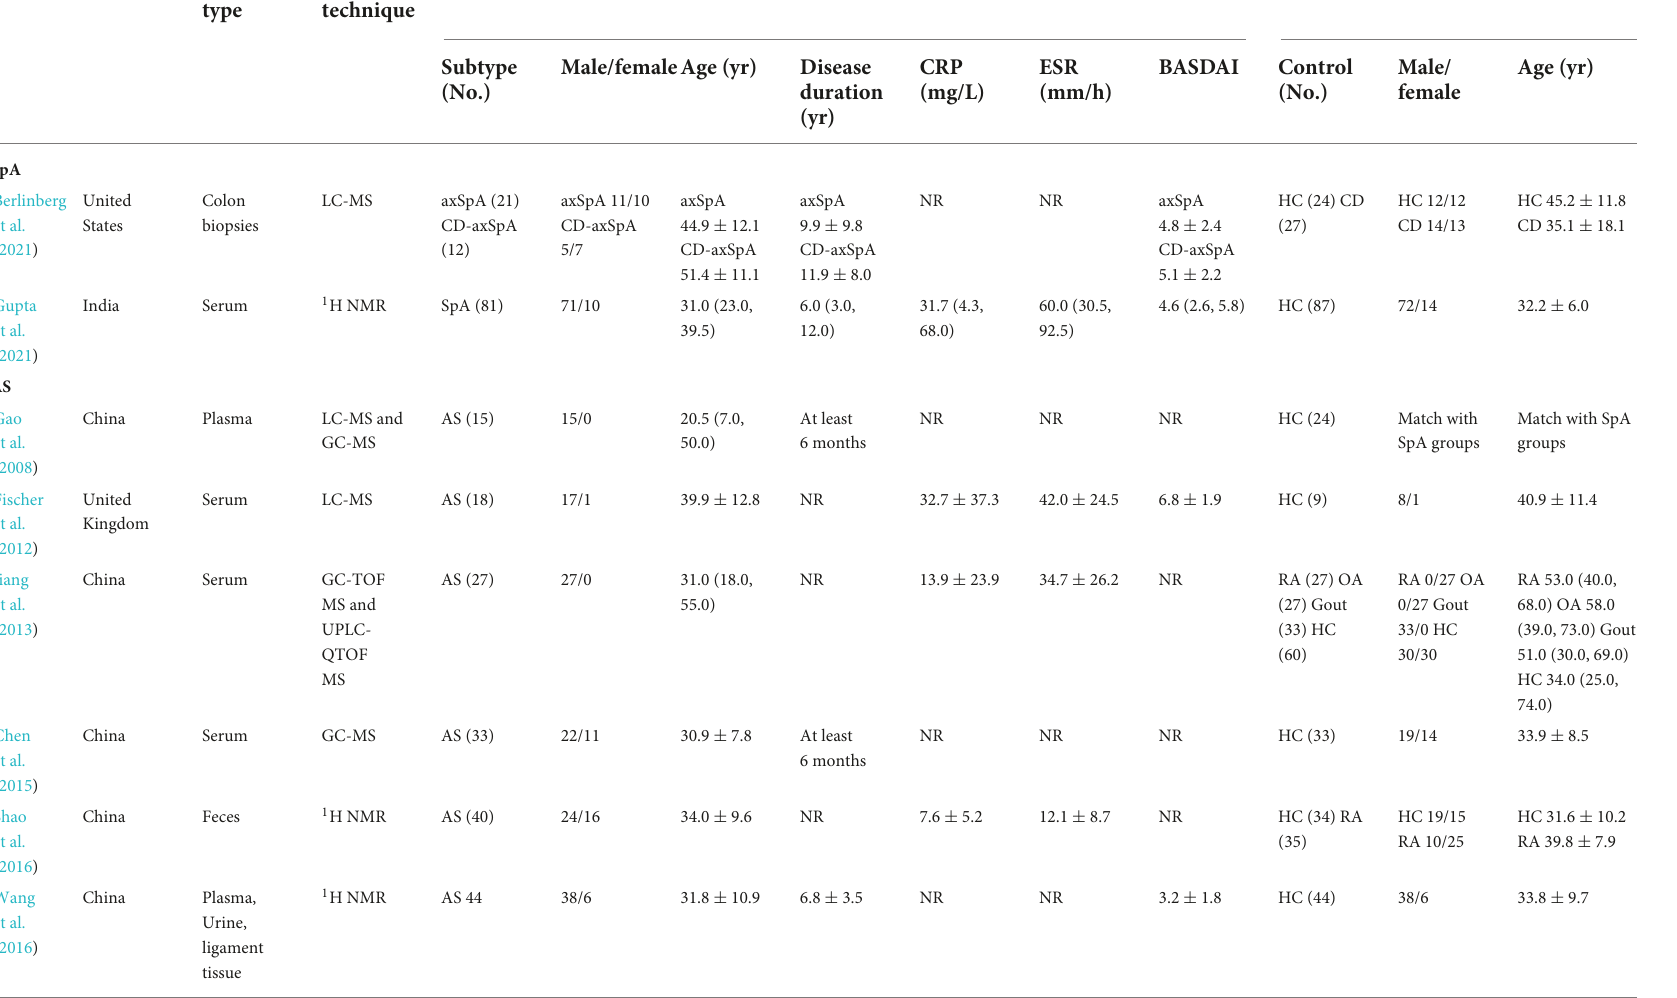
TABLE 1 Characteristics of studies included in the systematic review. Study